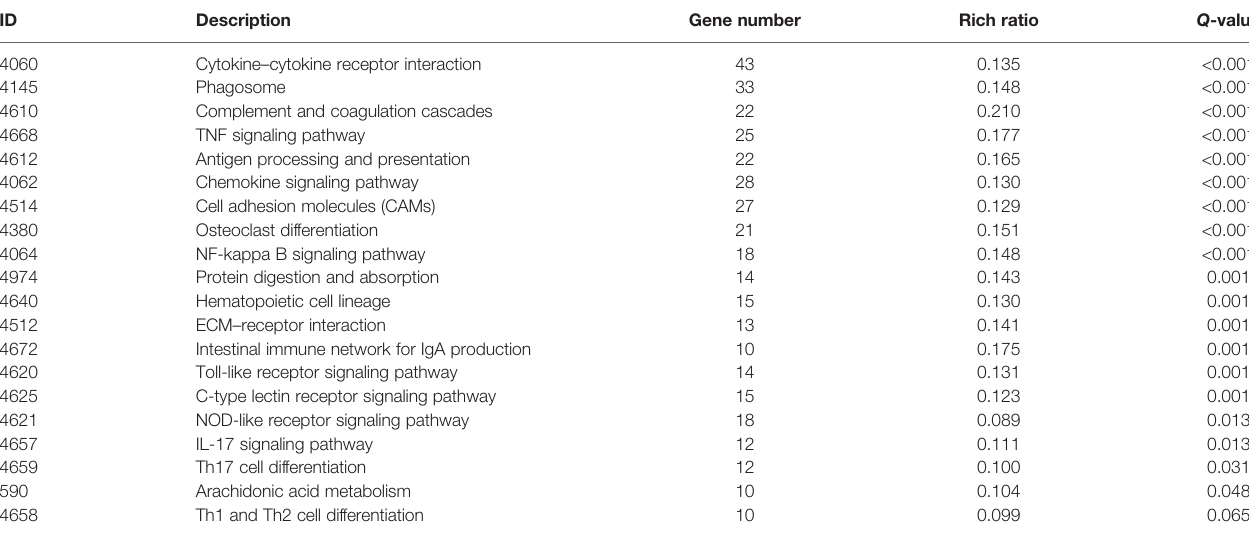
TABLE 2 | Signi fi cantly enriched pathways of DEGs using the KEGG